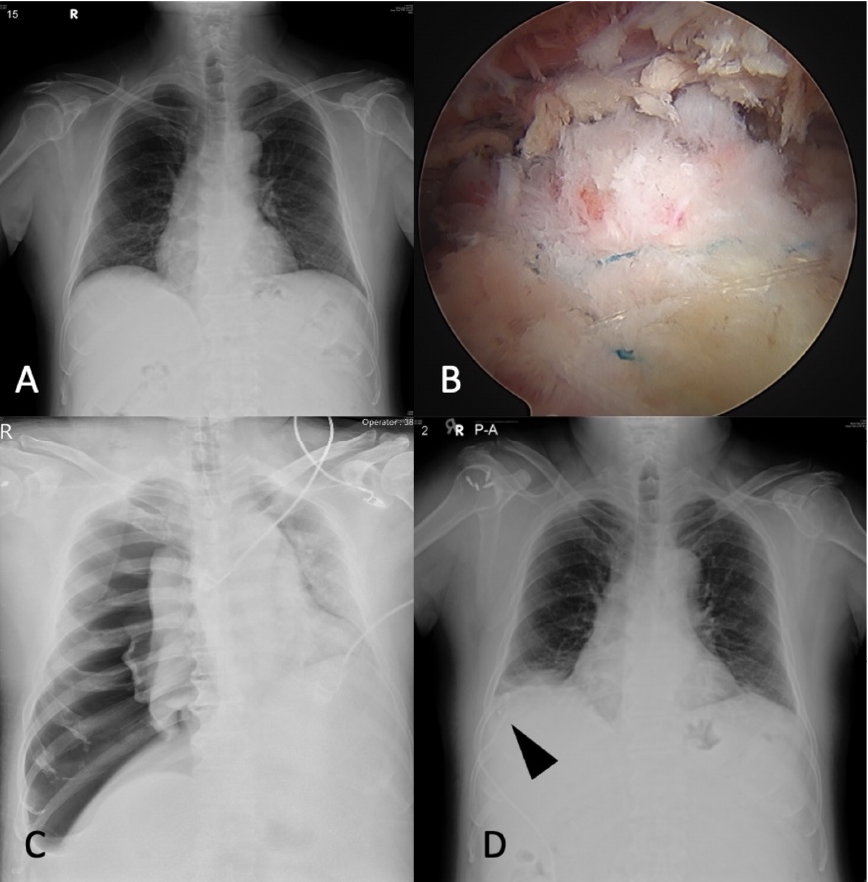
Figure 3. A 62-year-old male patient with ( A ) Preoperative chest X-ray was unremarkable. ( B ) Suture-bridge technique for right rotator cuff tear. ( C ) A large pneumothorax with mediastinum and trachea left shift after the surgery. ( D ) A chest pigtail drainage was placed smoothly. Arrowhead: pigtail drainage.